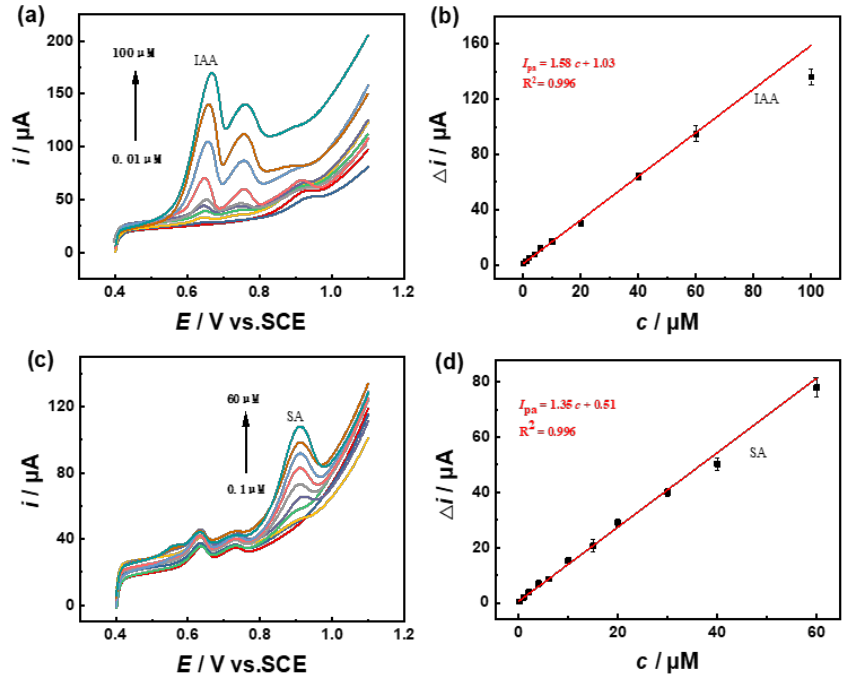
Figure 10. LSV curves of PPRONPs–CDs–MWCNTs/GCE in 0.1 M PBS (pH = 7.0) containing different concentrations of IAA ( a ) and SA ( c ), respectively; the linear correlation curve of peak currents vs. concentrations of IAA ( b ) and SA ( d ), respectively.